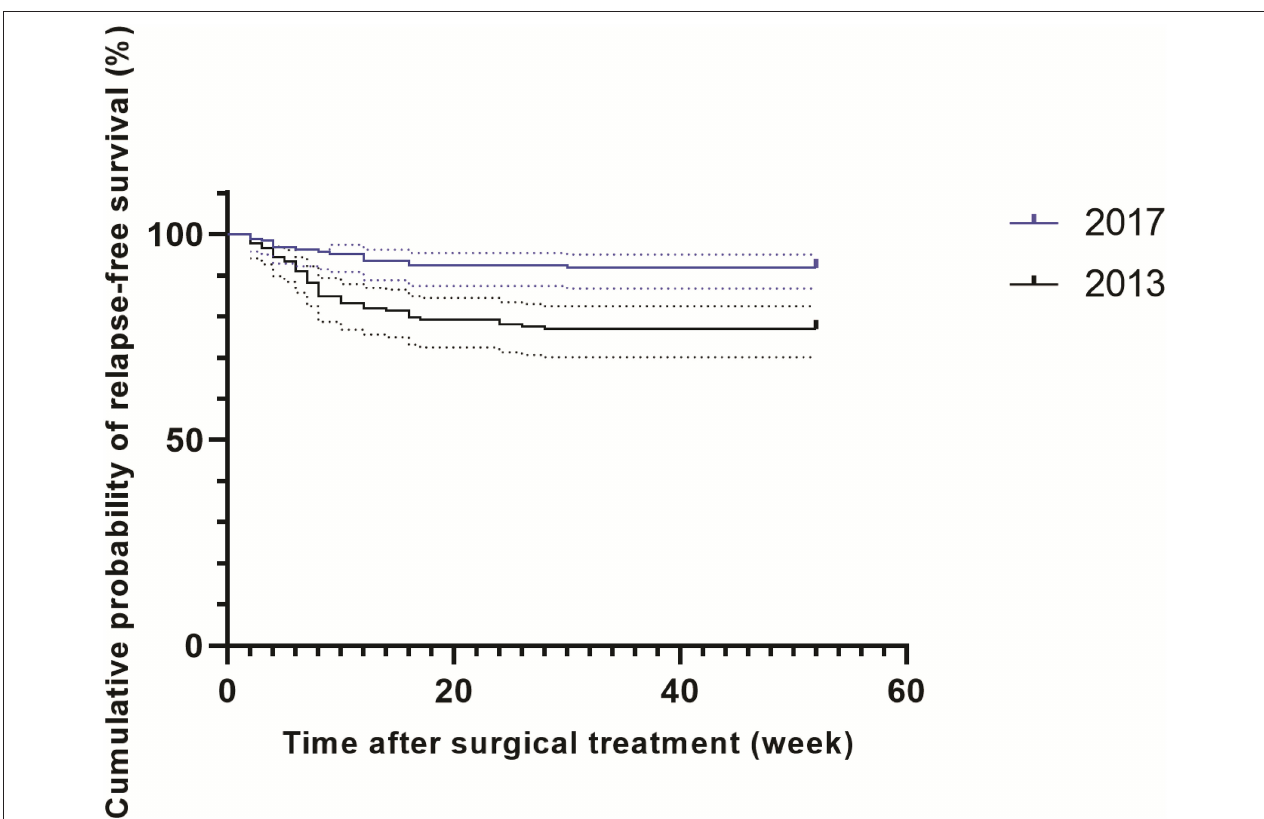
FIGURE 2 | Cumulative probability of relapse-free survival in patients with spinal